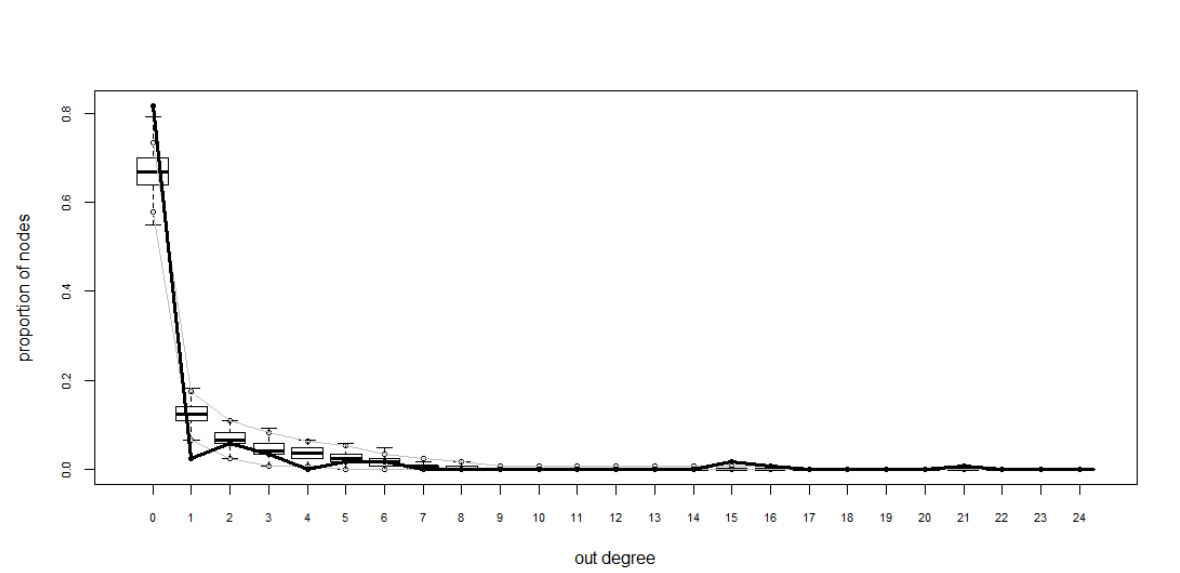
Figure A1.4. Goodness of Fit Diagnostics for Outdegree